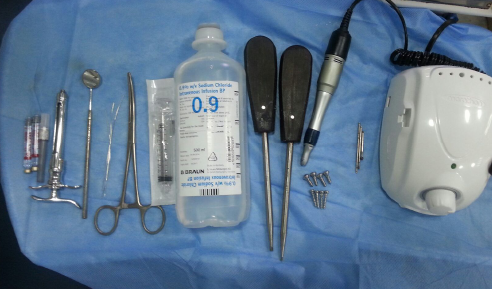
Figure 1: IMF screws with instruments set.